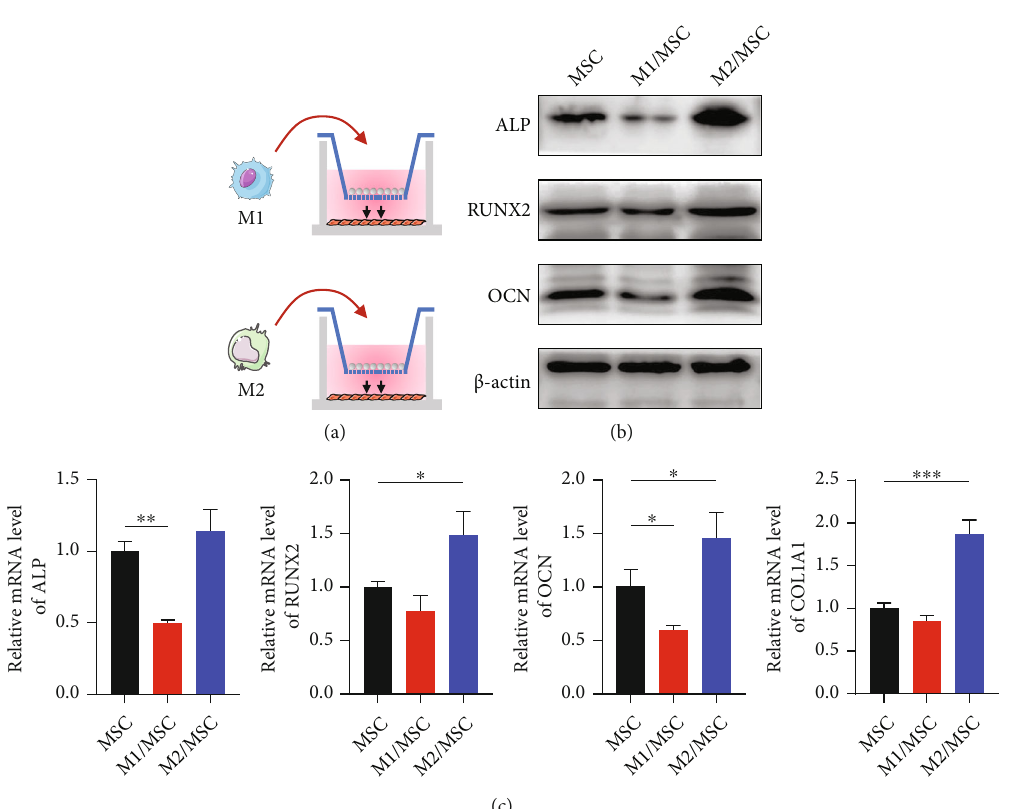
Figure 5: Indirect coculture of macrophages with UC-MSCs altered osteoblastic di ff erentiation ability. (a) Schematic graphs for M1 and M2 macrophages cocultured with UC-MSCs in Transwell plates (membrane pore = 0 : 4 μ m). (b) Detection of osteogenic-related proteins ALP, RUNX2, and OCN by western blot. (c) Quantitative analysis of osteogenic genes ALP, RUNX2, OCN, and COL1A1 by RT-qPCR. Data are presented as mean ± SD from triplicate experiments. ∗ P < 0 : 05 , ∗∗ P < 0 : 01 , and ∗∗∗ P < 0 : 001 mTOR (Figure 6(e)). Concurrently, osteogenesis proteins ALP, RUNX2, and OCN were decreased (Figure 6(e)). Over-